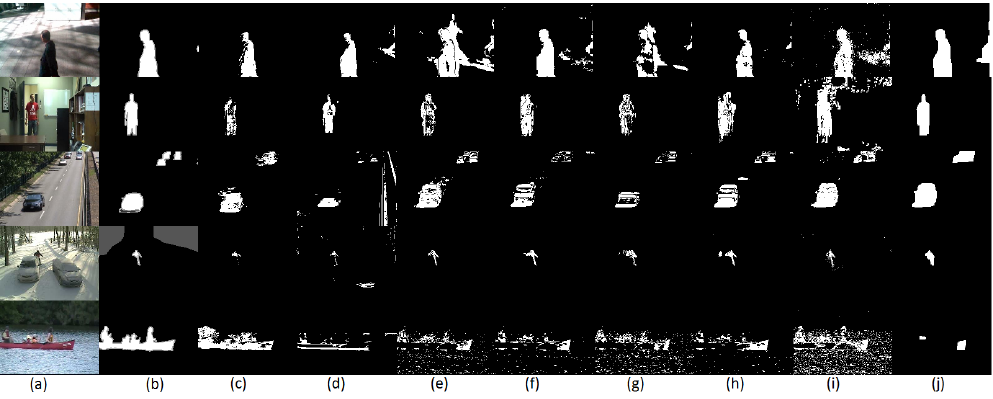
Figure 10. Visual effect comparisons through different methods on CDNet. ( a ) Source frames. ( b ) Ground truth. ( c ) The proposed method. ( d ) VBRPCA [26]. ( e ) GROUSE [27]. ( f ) MKFC [38]. ( g ) PCP [22]. ( h ) ViBe [34]. ( i ) GMM [21]. ( j ) Decolor